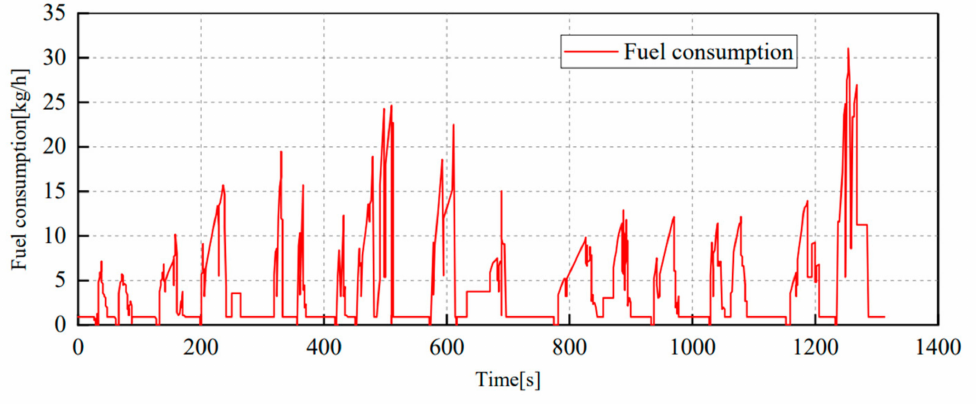
Figure 13. Engine fuel consumption